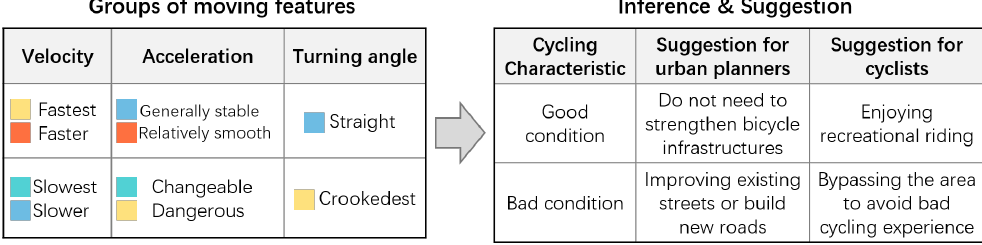
Figure 9. The grouping of moving attributes and the corresponding inference and